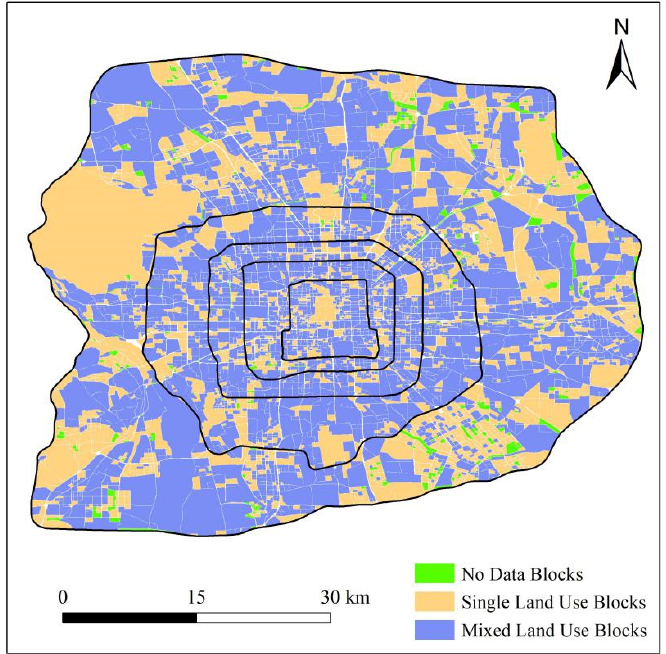
Figure 5. Spatial distribution of no data blocks, single-function blocks, and mixed-function blocks.